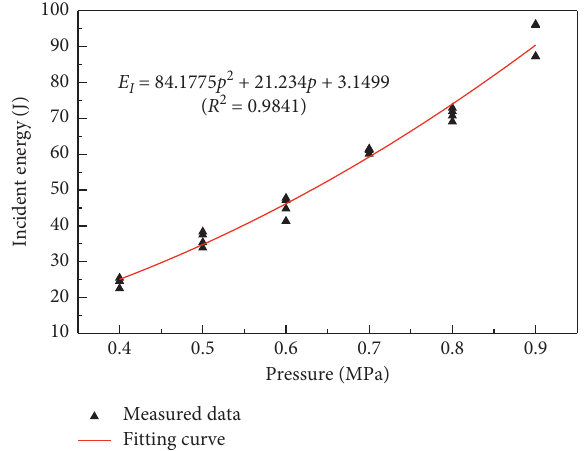
Figure 9: Relationship between incident energy and impact air